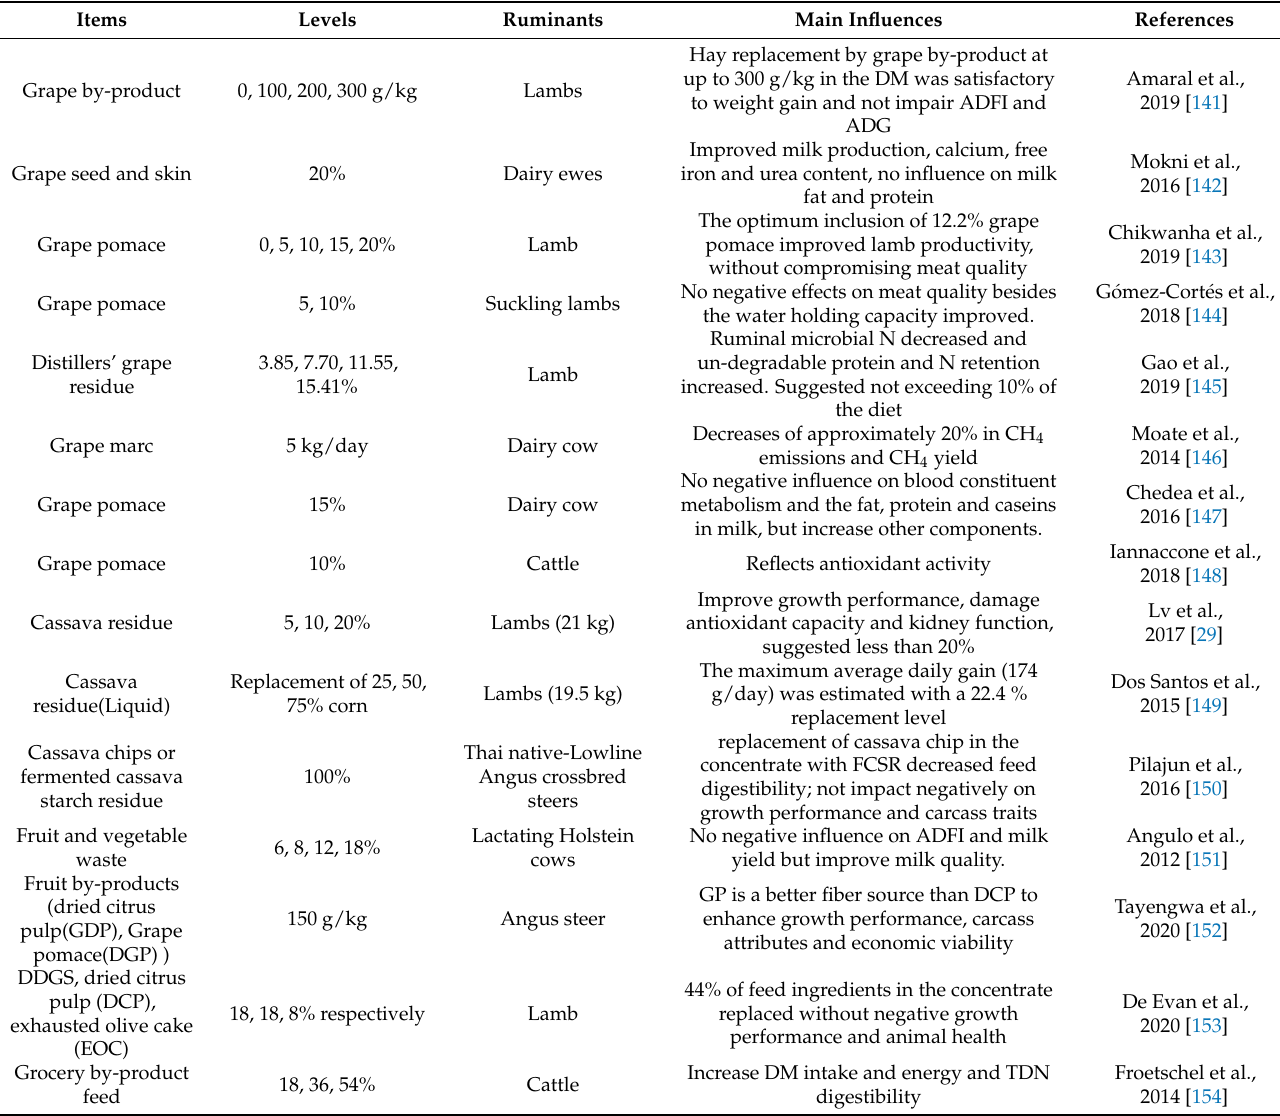
Table 5. Applications of agro-industry by-products as feeds in